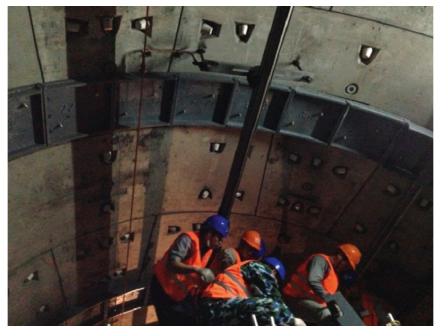
Figure 12: Reinforcement in the existing tunnel.